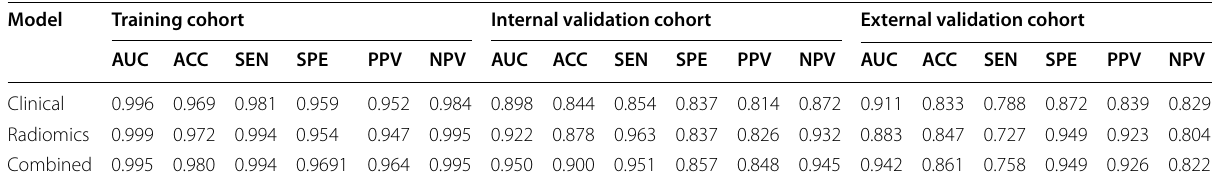
Table 6 Performance of the three models